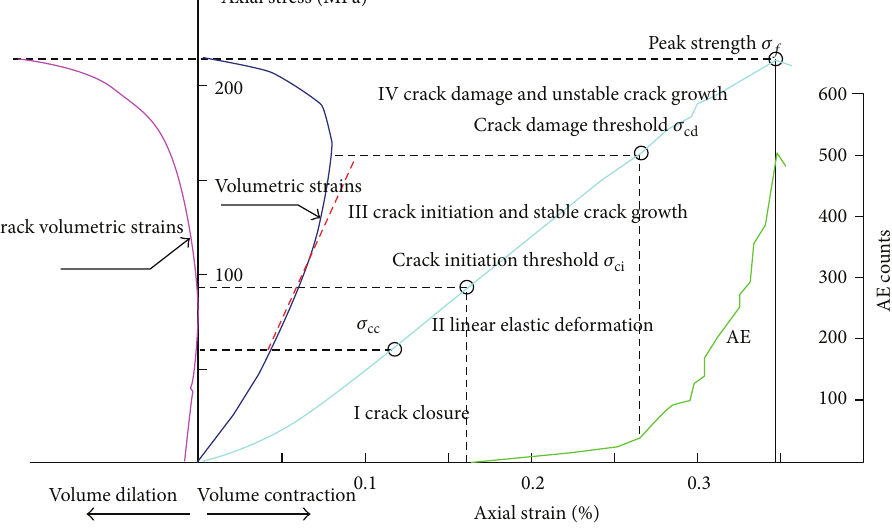
Figure 9: Schematic diagram of stress-strain curves of